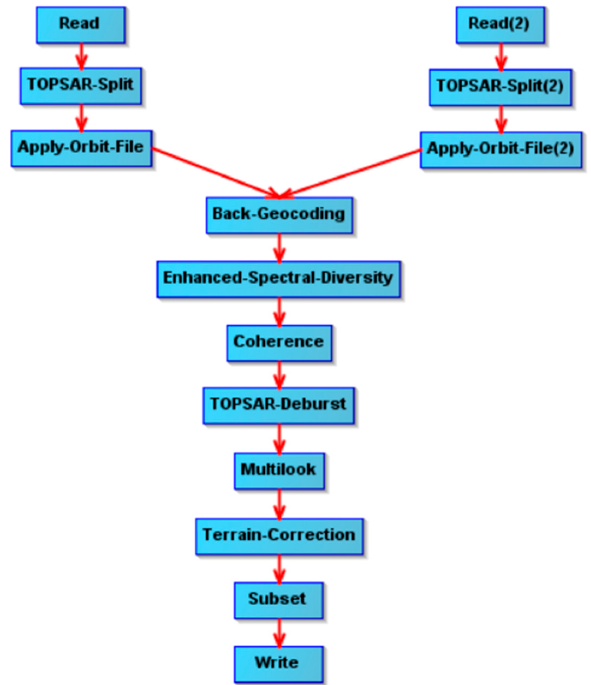
Figure 1. Preprocessing workflow used to produce Sentinel-1 interferometric coherence images in SNAP. The “Read” and “Read (2)” commands represent the two Sentinel-1 input files, while “Write” represents the output file. ISPRS Int. J. Geo-Inf. 2020 , 9 , x FOR PEER REVIEW